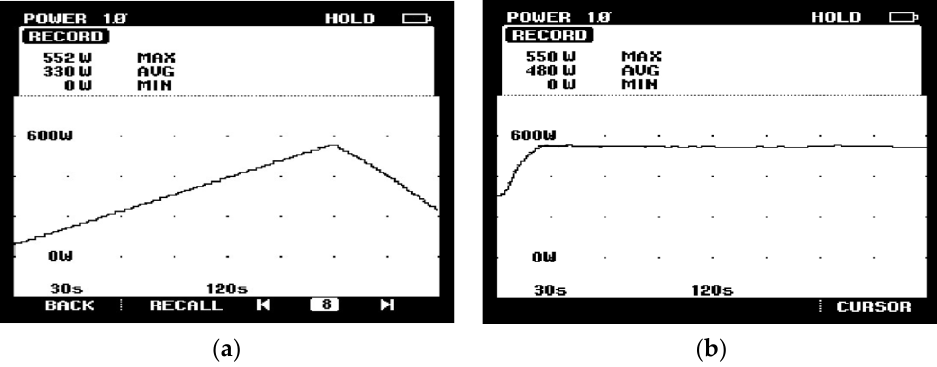
Figure 17. Power efficiency of the BBI.